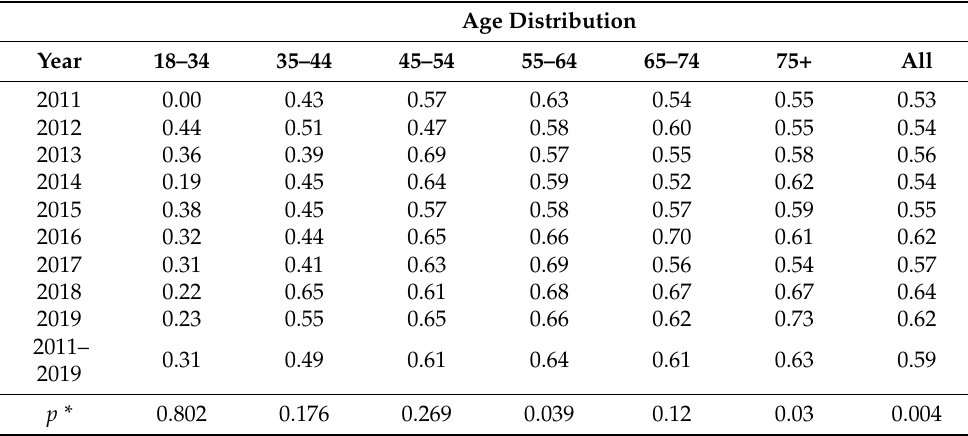
Table 8. HPN death rate during first year—Age